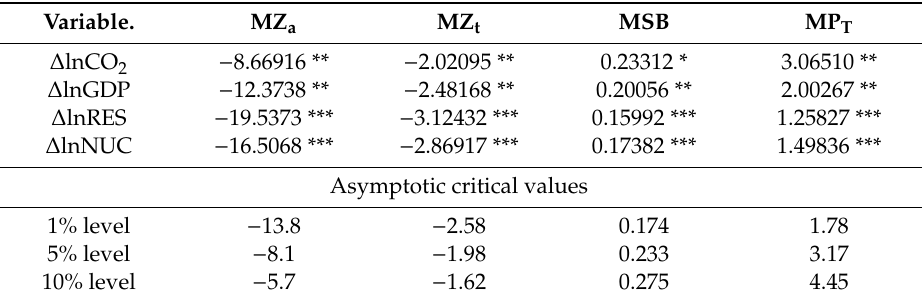
Table 2. The Ng‒Perron unit root test results for first differences of variables. Table 2. The Ng-Perron unit root test results for first di ff erences of variables. Variable.